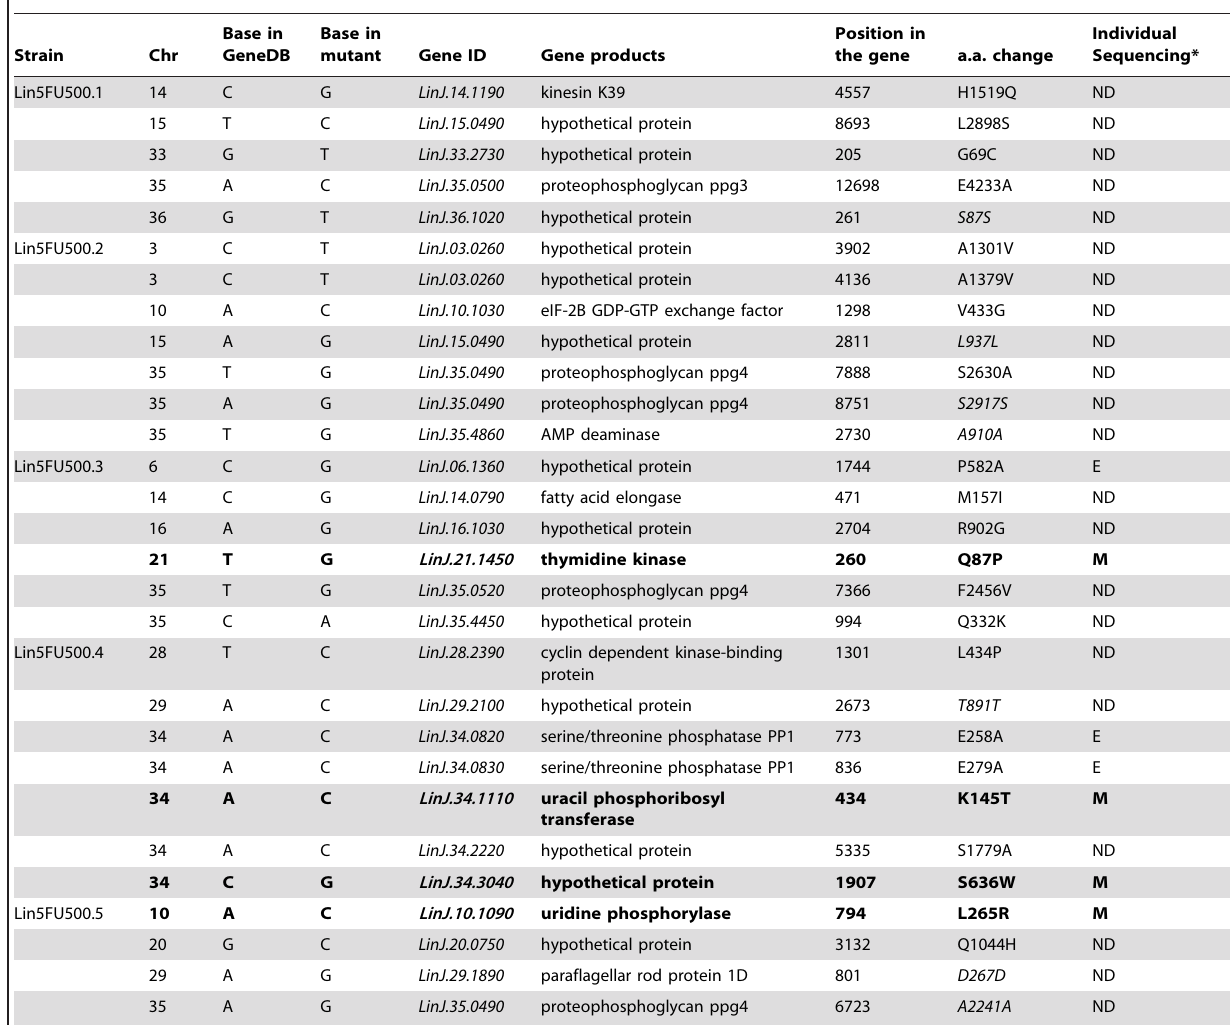
Table 2. Whole genome SNP discovery in 5-FU resistant